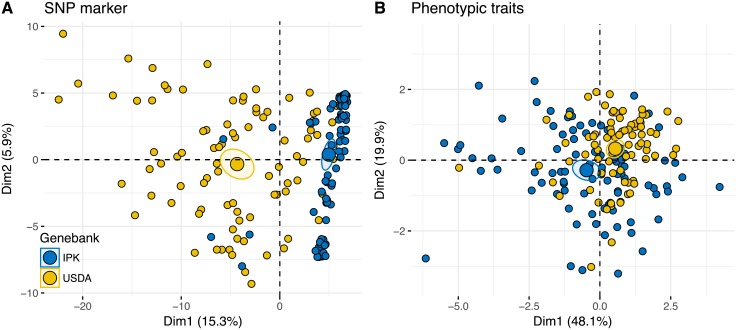
Principal component analysis (PCA) of SNP markers and phenotypic traits.(A) PCA of 1,444 GBS-derived SNPs without missing data in any of the accessions. (B) PCA of six phenotypic traits measured in two locations over three growing periods. In both PCA analyses, the two larger dots indicate the centroids and their confidence regions for the genebanks.